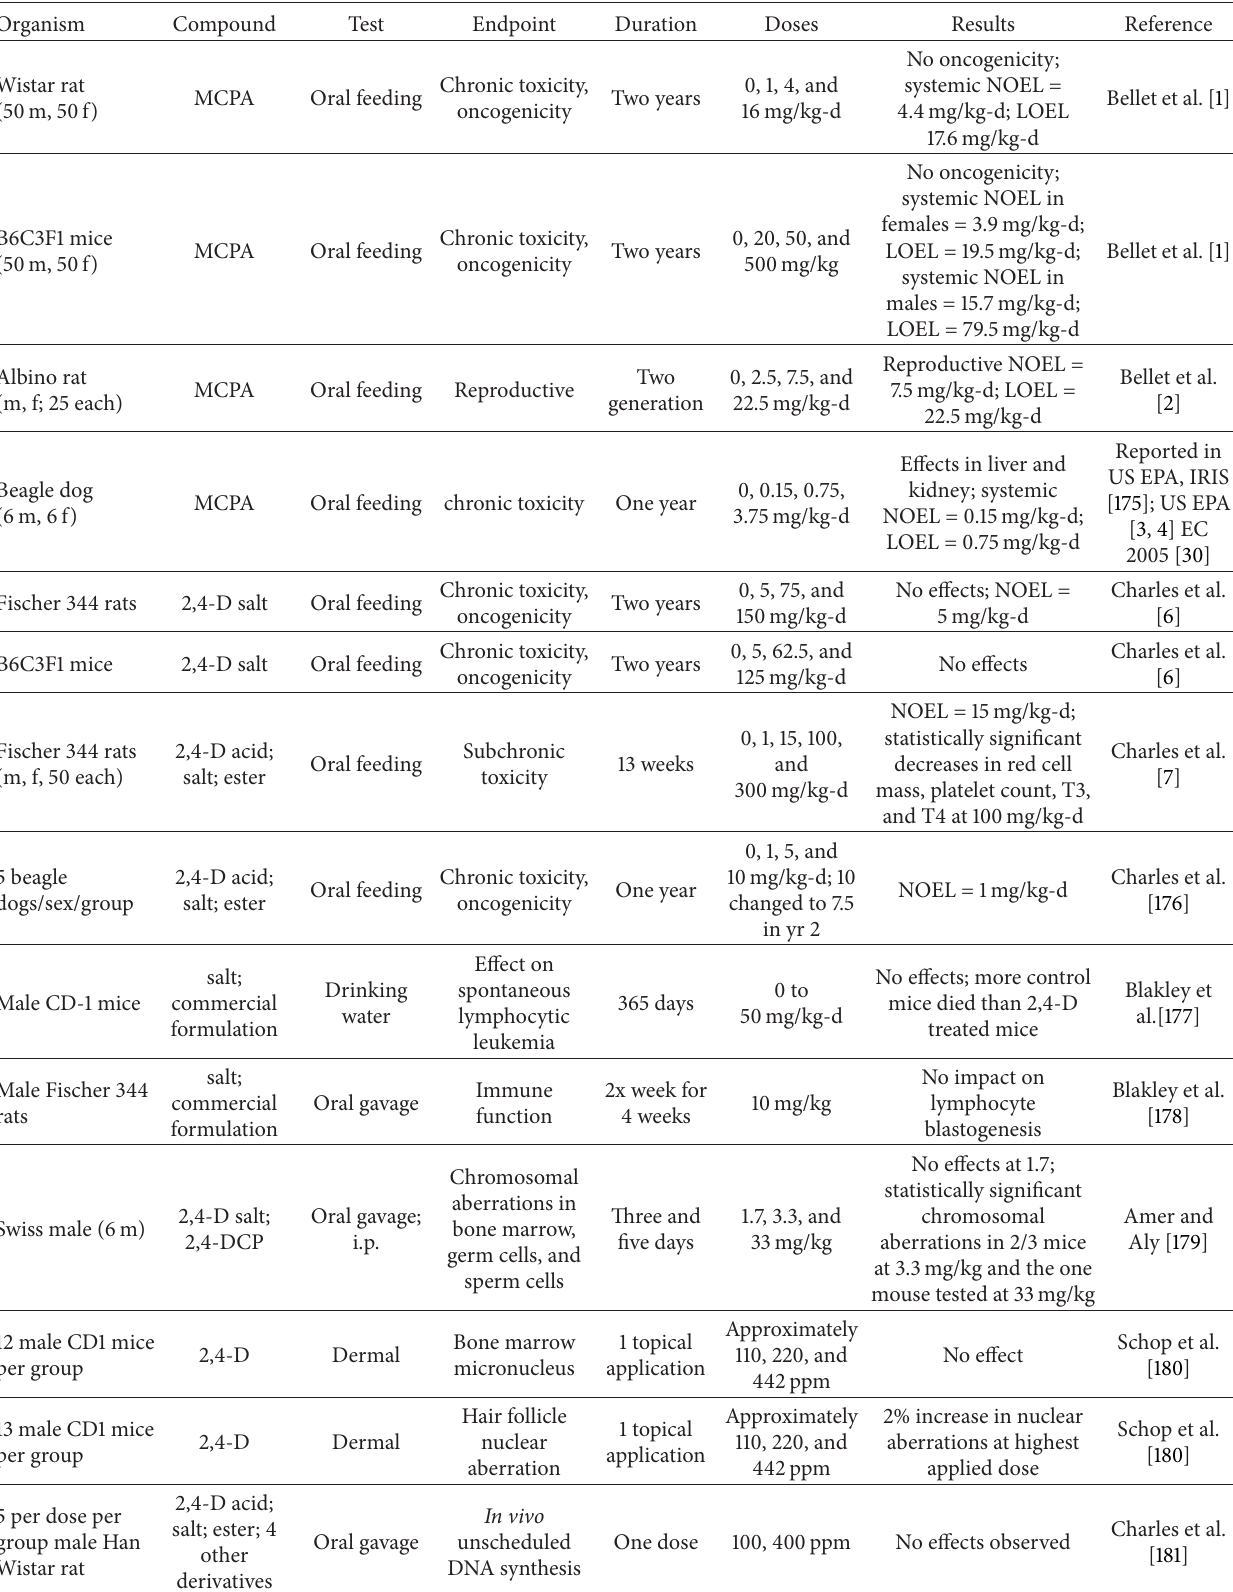
Table 6: In vivo animal